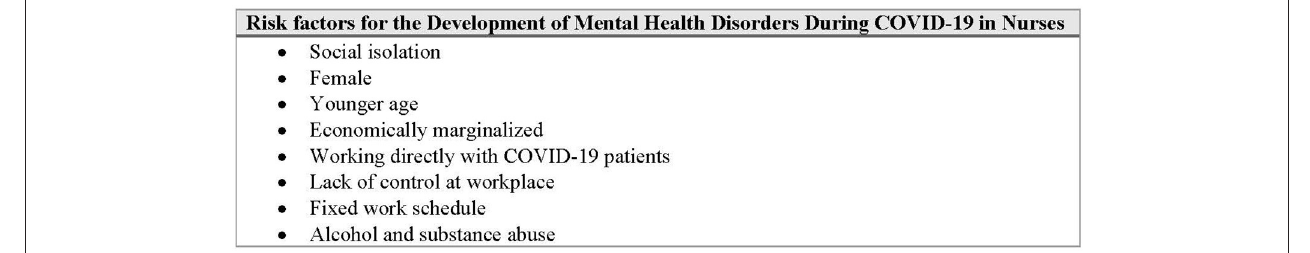
FIGURE 1 | Risk factors for the development of mental health disorders during COVID-19 in nurses.